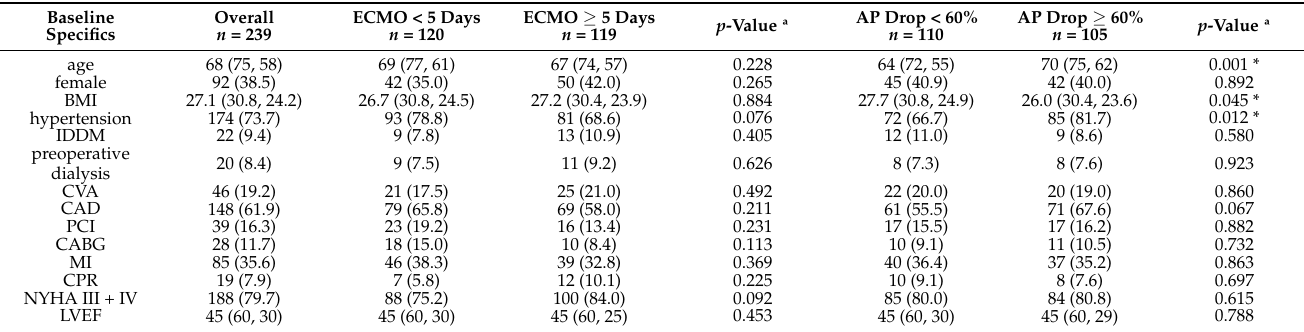
Table 1. Preoperative data.